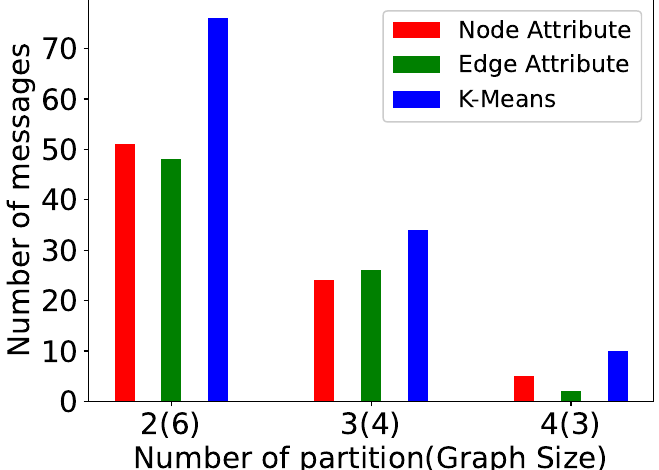
Figure 18. Messages sent for P-TSP for a varied number of partitions.